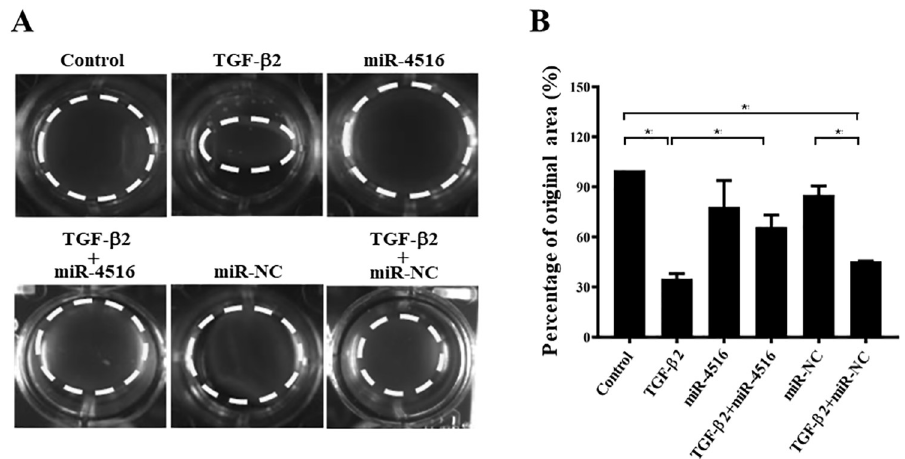
Fig 6. PVR was inhibited by miR-4516 overexpression in vitro. (A) ARPE-19 cells were pre-transfected with negative control or the miR-4516 mimic for 24 hours and then treated with TGF- β 2 (10 ng/mL) in the presence or absence of the miR-4516 mimic for 3 days. (B) Contraction or expansion was determined as a percentage of the original area. Results are presented as means ± standard errors of the mean of three independent experiments. � p < 0.05; �� p < 0.01; ns: not